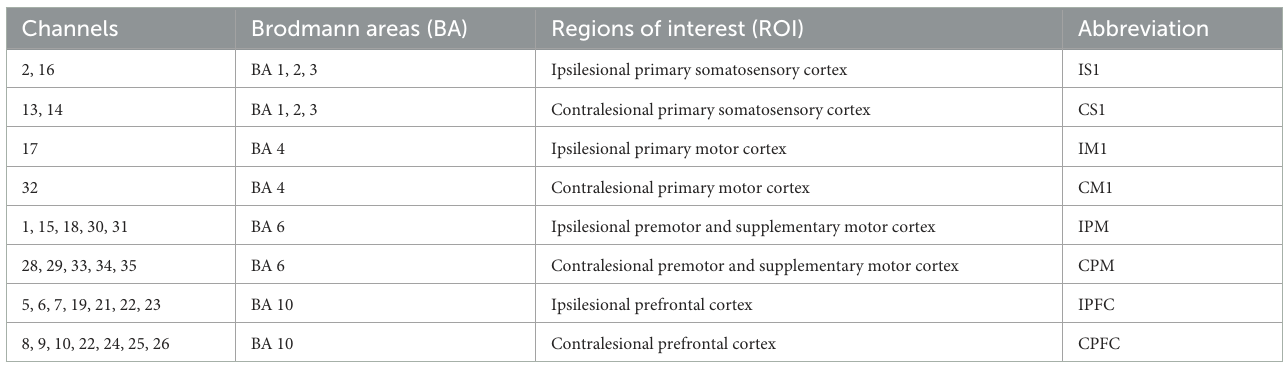
TABLE 2 Anatomically labeled fNIRS channel locations using Brodmann